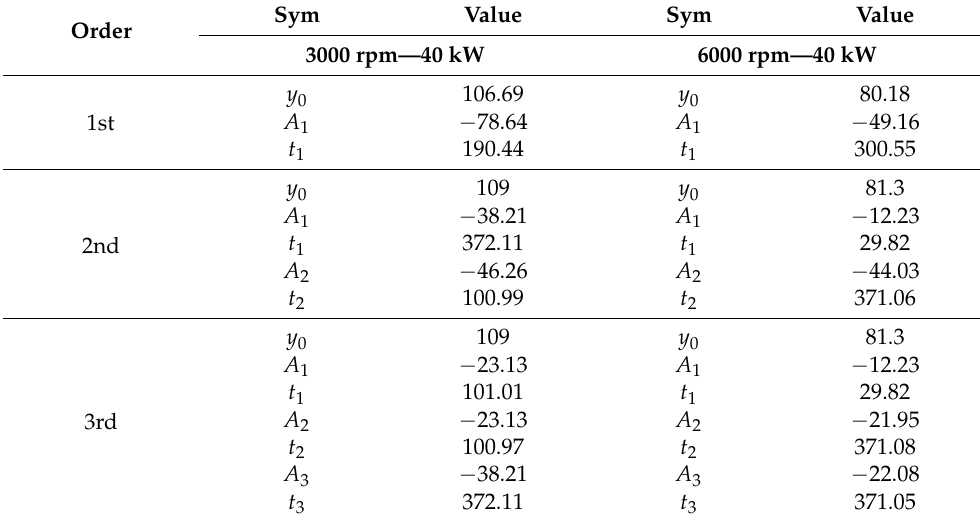
Table 7. Loss value of IPMSM parts.